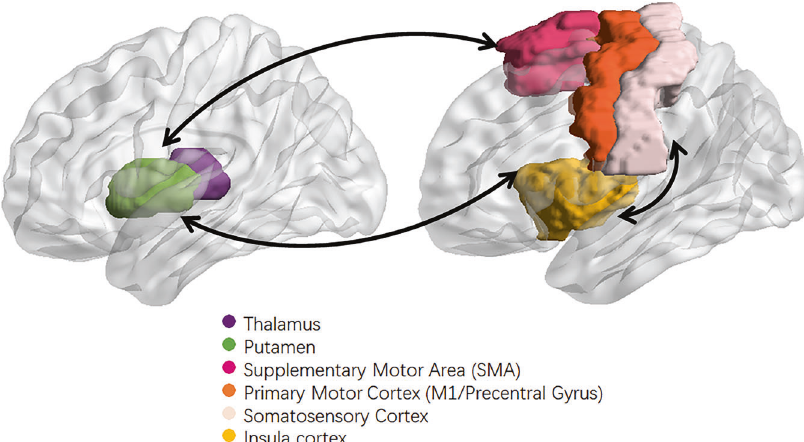
Fig. 6 Sensorimotor network. The sensorimotor network (SMN) mainly comprises the motor cortex (precentral gyrus, premotor and supplementary motor cortex) and middle cingulate cortex, somatosensory cortex (postcentral gyrus and parietal cortex), auditory cortex (superior temporal gyrus), as well as visual cortex (occipital cortex and associated dorsal parietal and inferior temporal areas) and is involved in exteroceptive awareness and motor